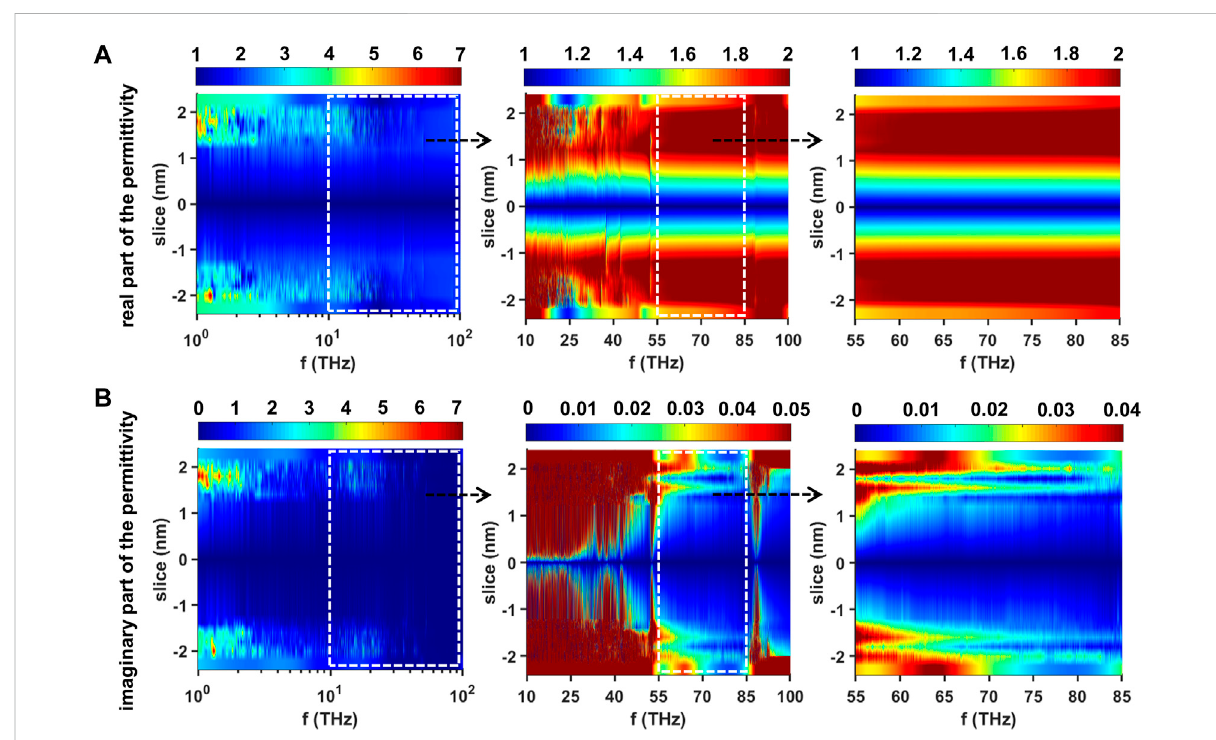
FIGURE 9 Dielectric spectra of the equilibrated membrane-water system in the range of 1 – 100 THz (A) Real part of the permittivity in the range of 1 – 100 THz (left), 10 – 100 THz (middle) and 55 – 85 THz (right) and (B) imaginary part of the permittivity in the range of 1 – 100 THz (left), 10 – 100 THz (middle)and55 – 85 THz(right). Thedashedrectanglesareusedtooutline theregionsweareinterested.Eachregionisfurtherenlargedandredrawn in its right adjacent sub fi